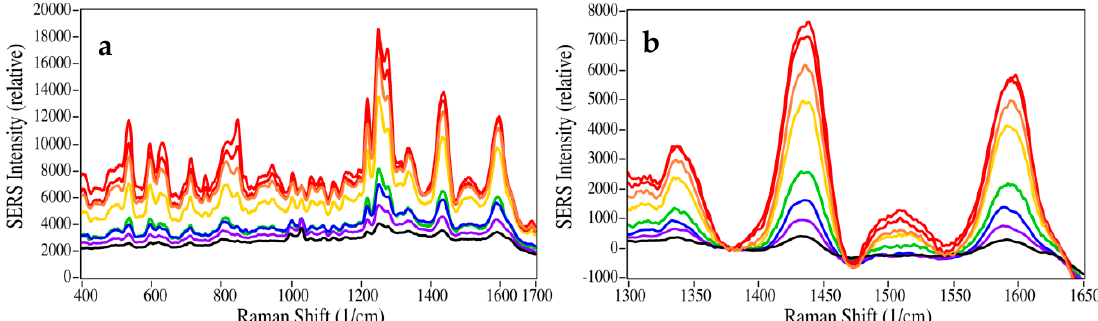
Figure 2. SERS of codeine at 50, 25, 10, 5, 1, 0.5, 0.25, and 0.1 µg/mL. ( a ) Full spectral view as measured, and ( b ) expanded view of the 1435 cm − 1 peak, with the baseline set to 0 at 1380 cm − 1 . Conditions: 40 mW at 785 nm, 3-sec scan per spectrum.